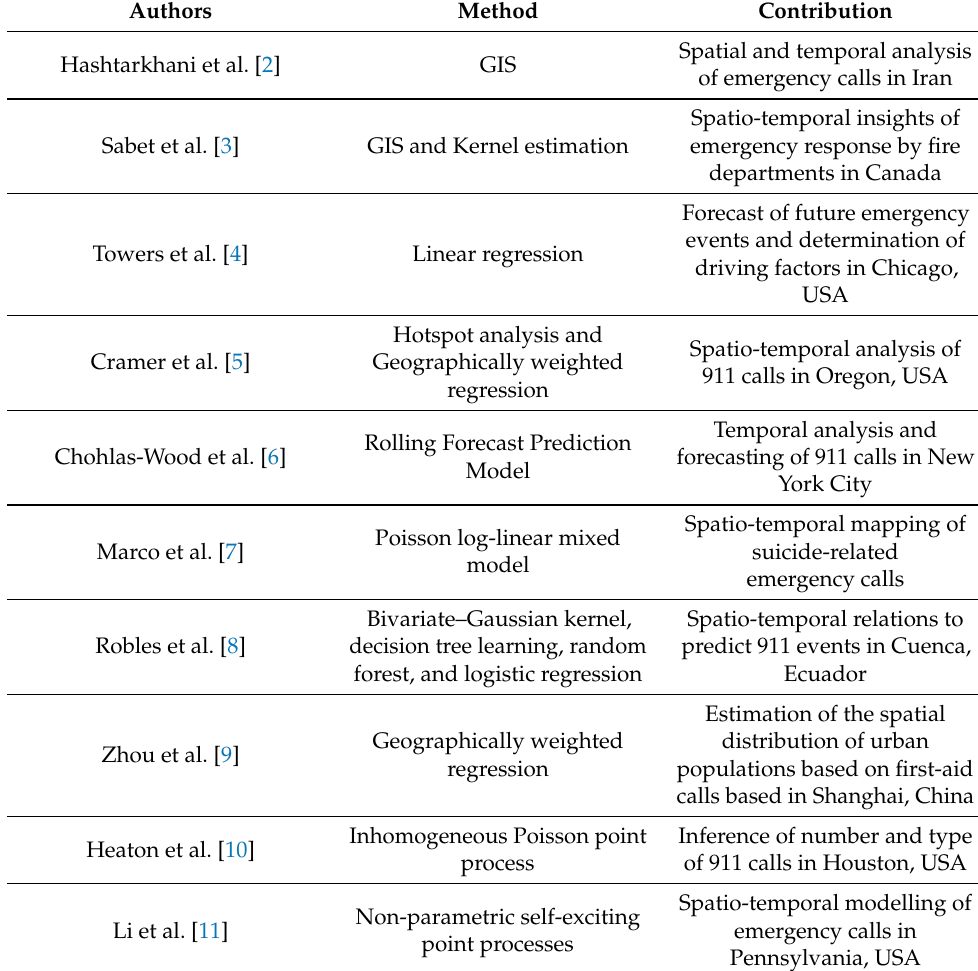
Table A1. Literature review of spatio-temporal models for analysing and predicting emergency